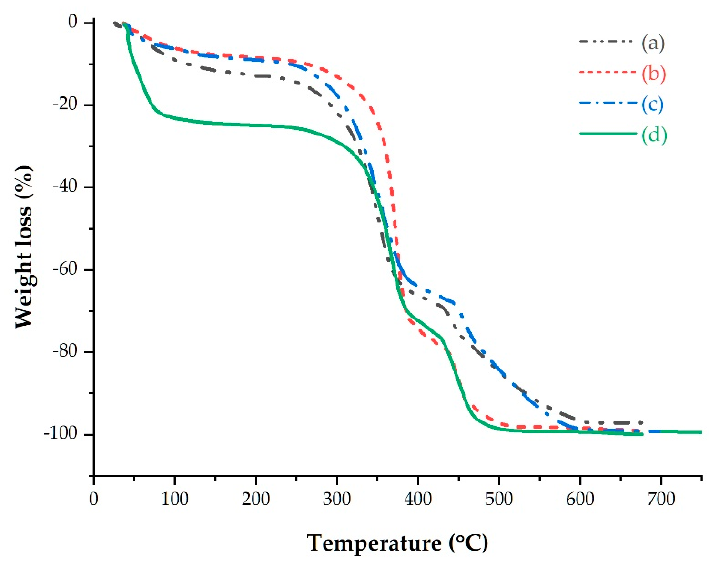
Figure 7. TGA graphs of ( a ) raw, ( b ) dewaxed, ( c ) alkalized, and ( d ) bleached fibers.